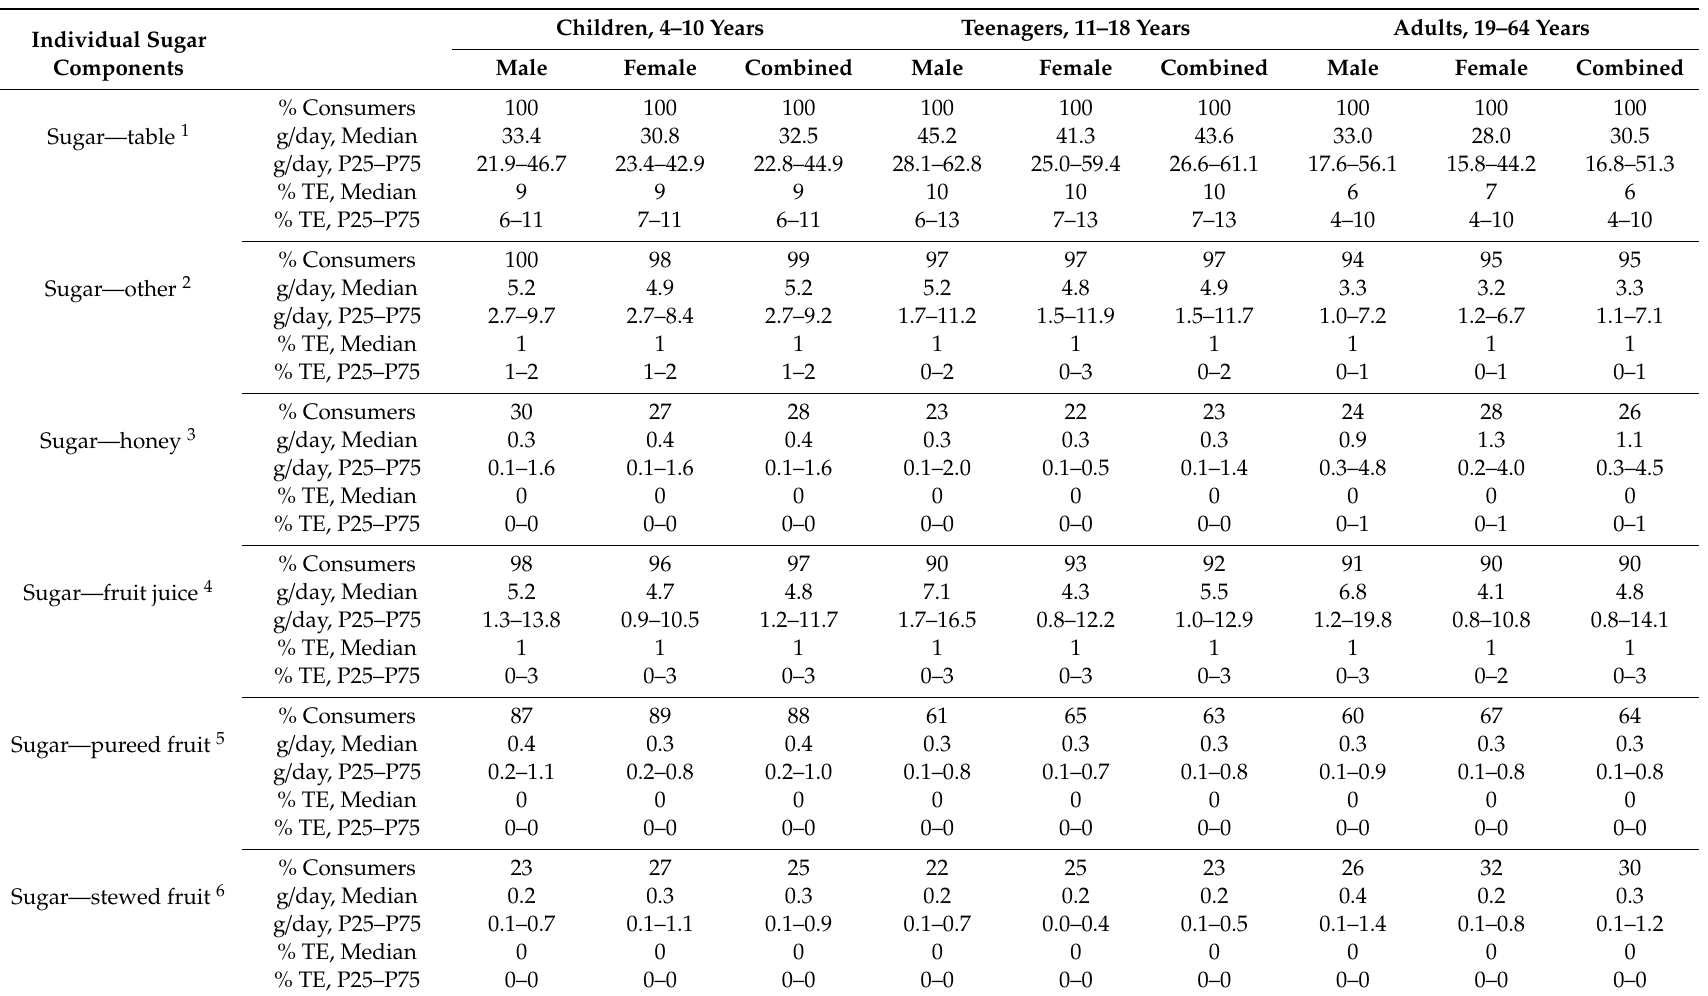
Table 3. Daily intakes of individual sugar components by age and sex (NDNS 2014–2016) (consumers